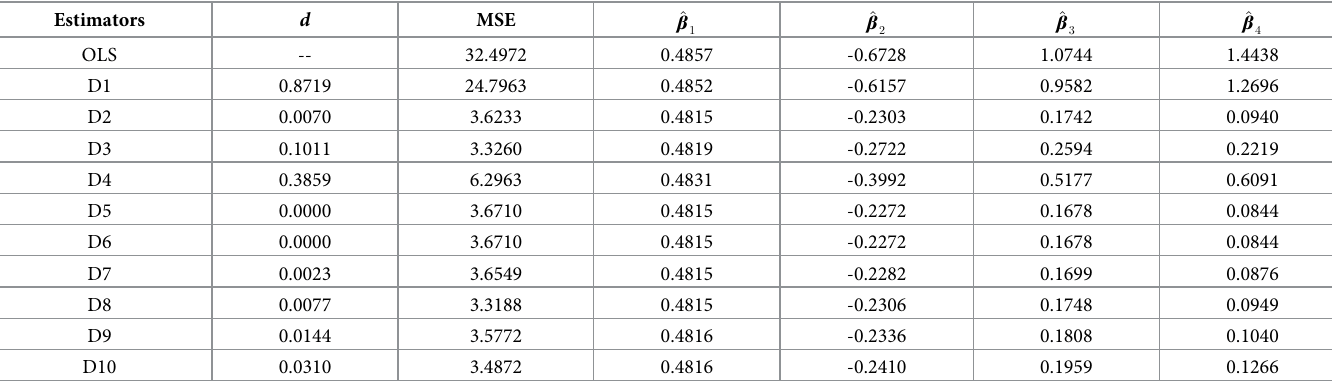
Table 7. Estimated values for d , MSE and regression coefficients of Tobacco